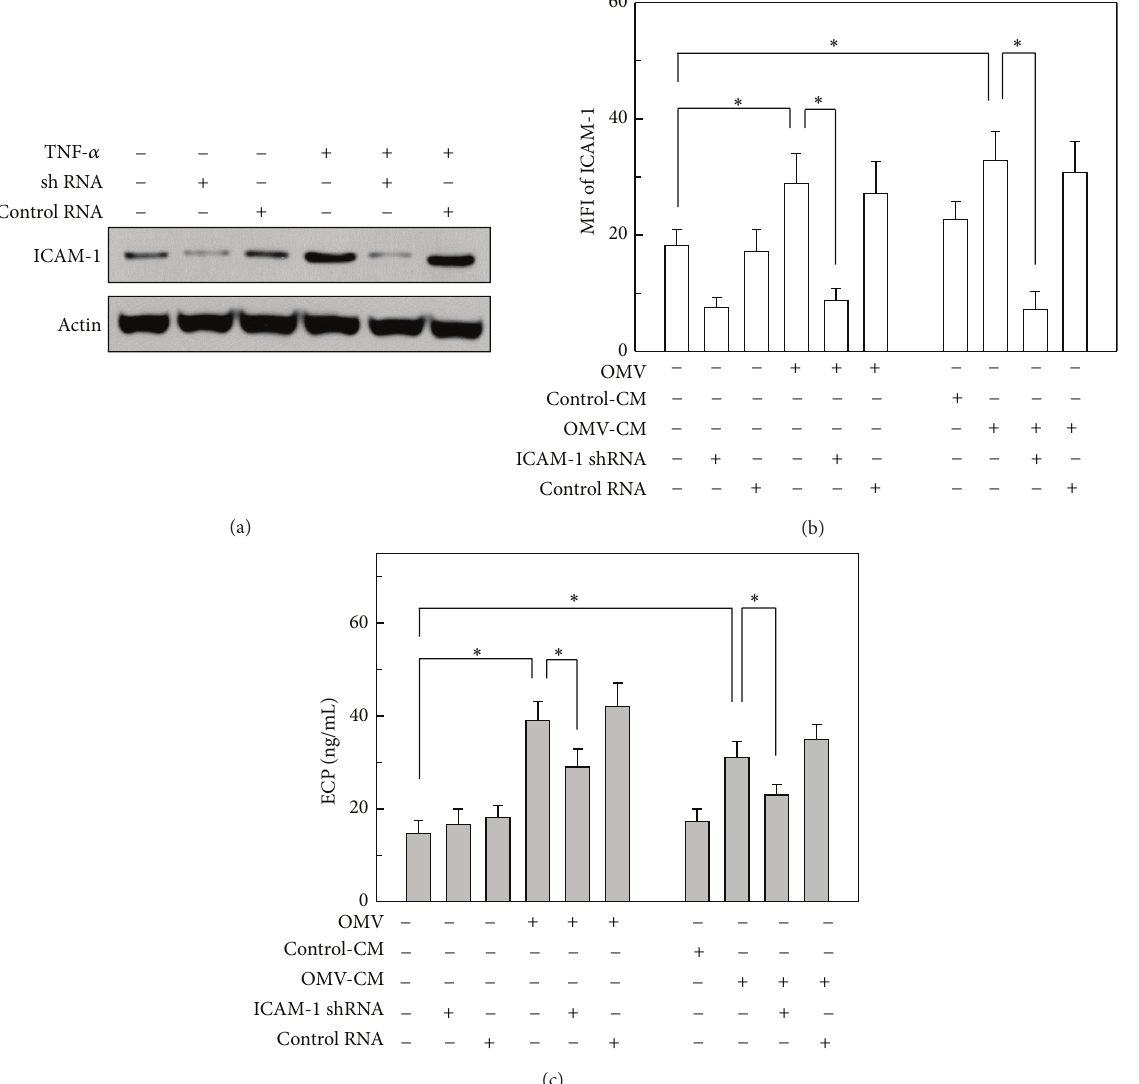
Figure 6: Relationship between ICAM-1 suppression and ECP release from eosinophils. (a) Primary human gastric epithelial cells were transduced with lentivirus harboring either shRNA directed against ICAM-1 or control shRNA. Transduced cells were then stimulated with TNF- 𝛼 (20 ng/mL) for 1h. The cellular levels of ICAM-1 and actin were determined by immunoblot analysis. Results are representative of more than three independent experiments. (b) Transduced or nontransduced gastric epithelial cells were stimulated with OMVs (200 𝜇 g/mL), OMV-CM (50% v/v), or control-CM (50% v/v) for 24 h. Cells were stained with a mAb against ICAM-1 and then analyzed by flow cytometry. Data are represented as MFI ± SEM ( 𝑛 = 5 ). (c) Transduced or nontransduced gastric epithelial cells were exposed to OMVs (200 𝜇 g/mL) for 24h and then washed twice in PBS. OMV-exposed gastric epithelial cells were cocultured with human eosinophils for 24 h (left panel). Transduced or nontransduced gastric epithelial cells were stimulated with control-CM (50% v/v) or OMV-CM (50% v/v) for 24 h and then washed twice in PBS. Finally, human eosinophils were cocultured with either control-CM-stimulated or OMV-CM-stimulated epithelial cells for 24 h (right panel). The concentration of ECP in each culture supernatant was measured by ELISA (mean ± SEM, 𝑛 = 5 ). ∗ 𝑃 < 0.05